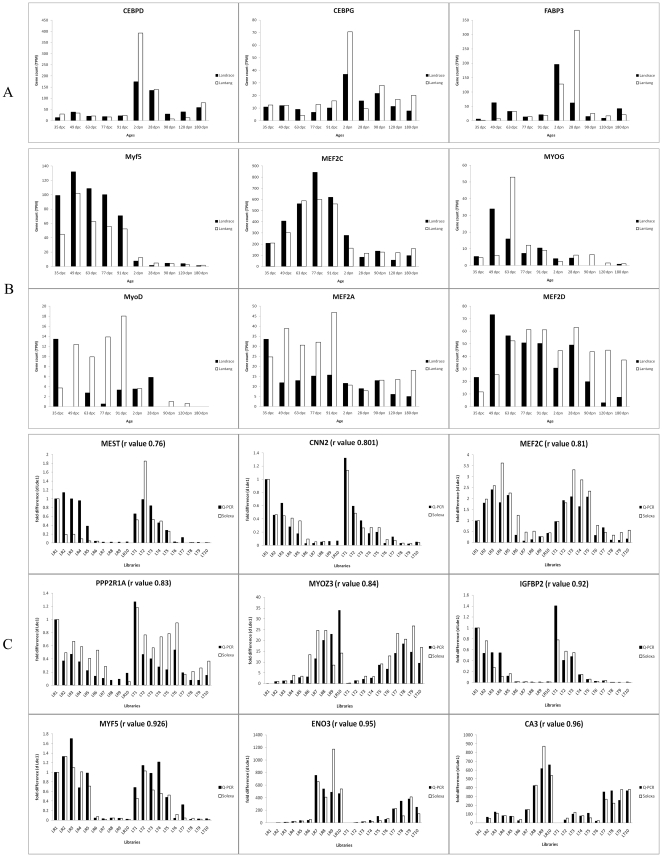
The expression patterns of myogenesis and adipogenesis genes (A, B) and Q-PCR validation of sequencing data (C).(A) The expression pattern of genes could relate to adipogenesis. The vertical axis indicates the normalized gene expression level in breed or stages; dpc indicates prenatal and dpn indicates postnatal. (B) The expression patterns of MRF and MEF2 families. (C) Validation of sequencing data by Q-PCR. The vertical axis indicates the fold changes of transcript abundance in 20 samples compared to the LR 1. The r value indicates Spearman's Correlation between the two methods.